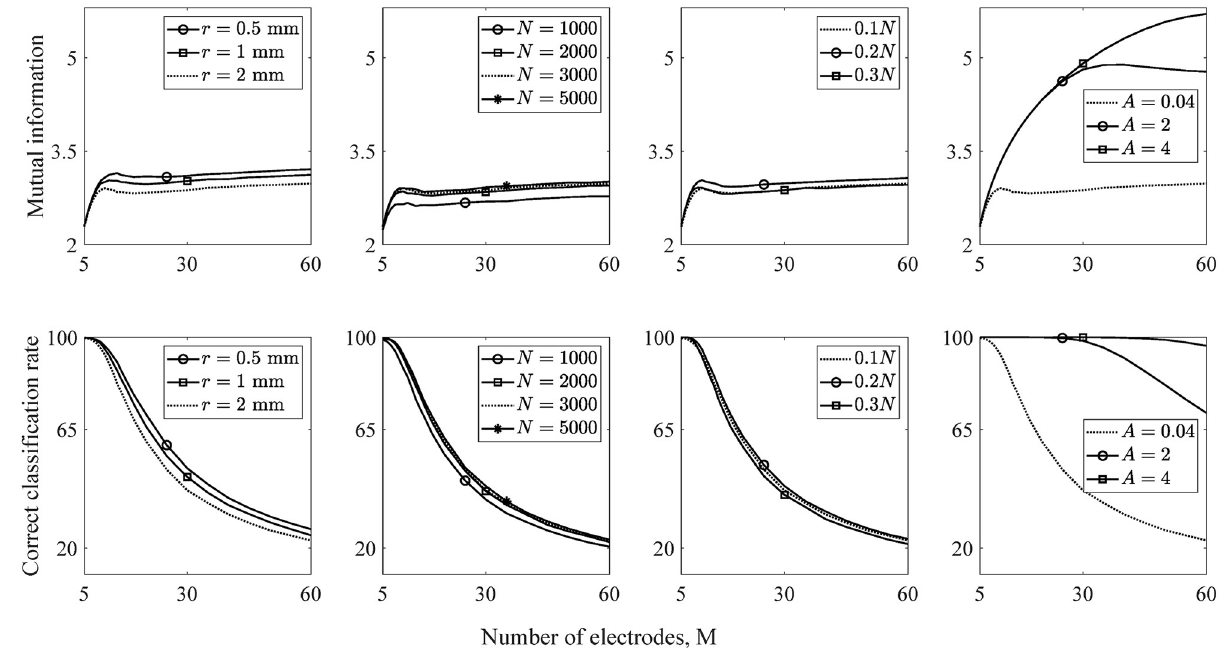
Fig 6. Model performance with ranges of parameter choices. The top and bottom rows respectively show mutual information and the percentage of correct electrode discrimination vs. the number of electrodes. The columns from left to right show the sensitivity to r , N , C e , and A , respectively.